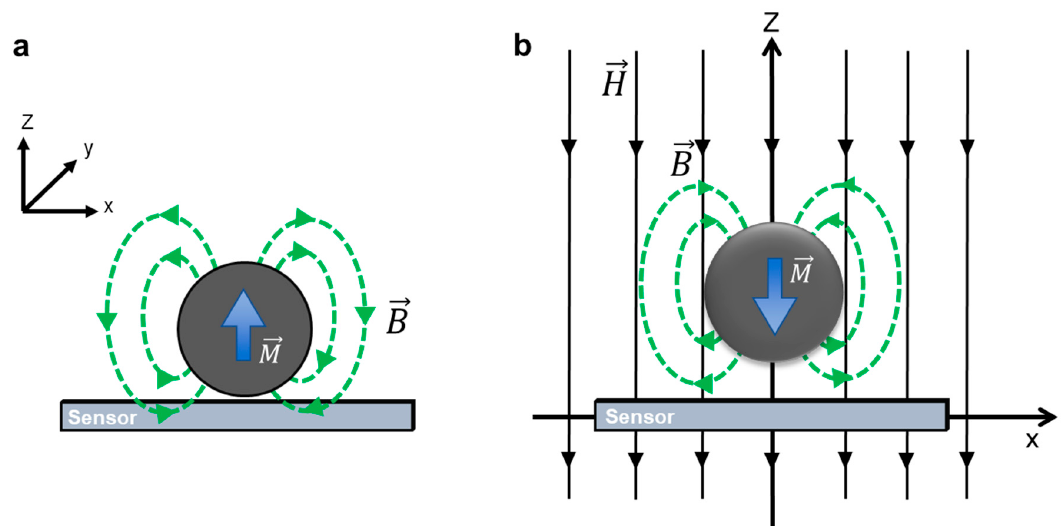
Figure 3. Schematics of stray magnetic field detection of magnetic beads ( a ) without an external magnetic field. Reprinted with permission from Ref. [43]. Copyright 2022 Elsevier, and ( b ) with an applied external magnetic field. Reprinted with permission from Ref. [27]. Copyright 2022 AIP Publishing.